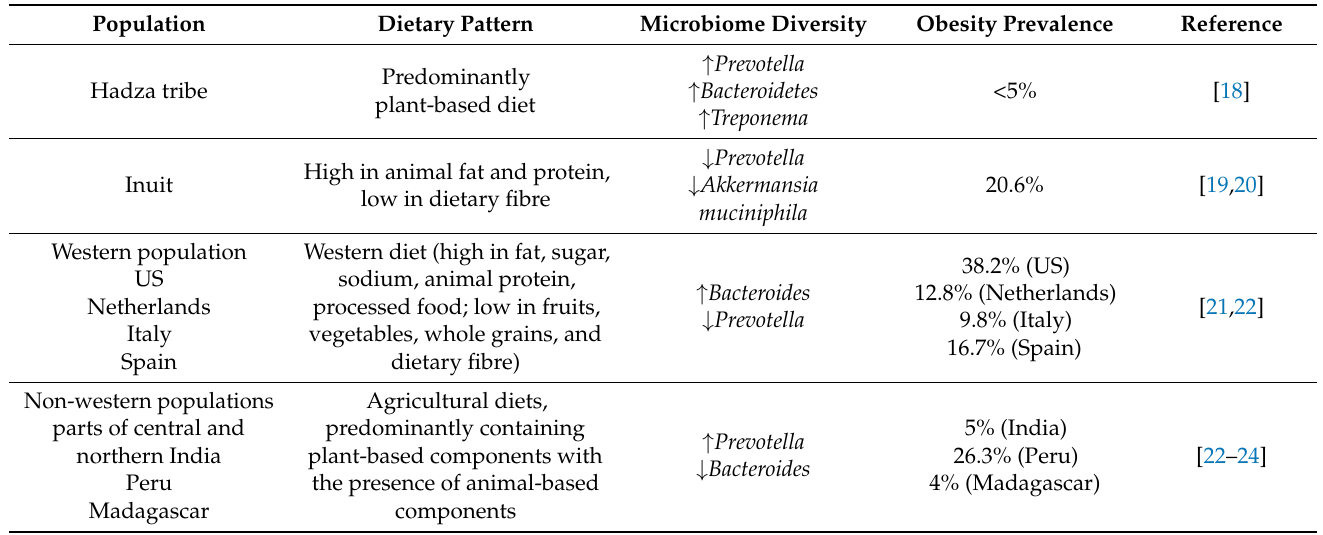
Table 1. Obesity prevalence and microbiome diversity characteristics in specific population group ↑ : increased; ↓ :